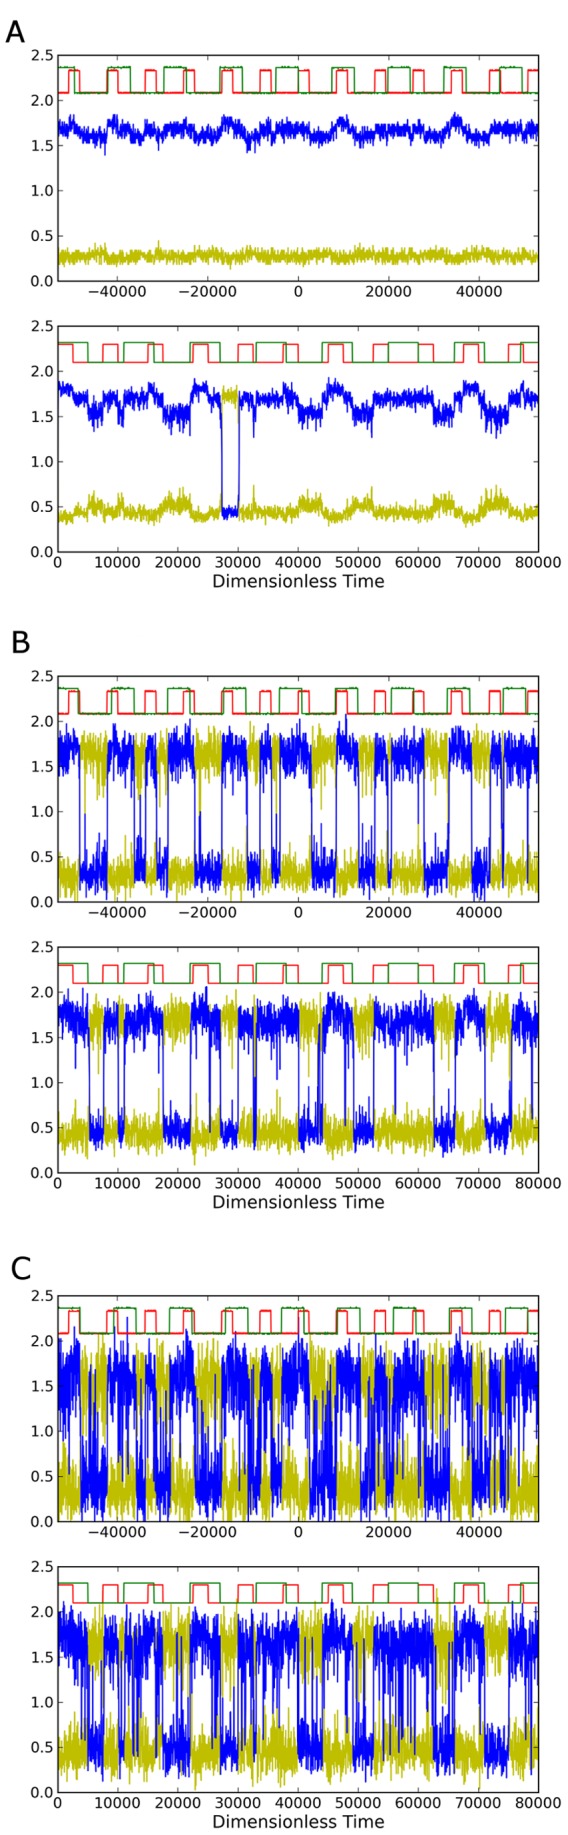
Time series for circuit measurements (upper graph) and simulations (lower) for different noise strengths showing OR/NOR LSR.Panel (b) has noise level within the optimal range for displaying OR/NOR characteristics. Noise strengths in simulation and in circuit are: (a)  and , (b)  and , (c)  and . Voltages and times for the circuit measurements have been converted to dimensionless quantities as described in the text.